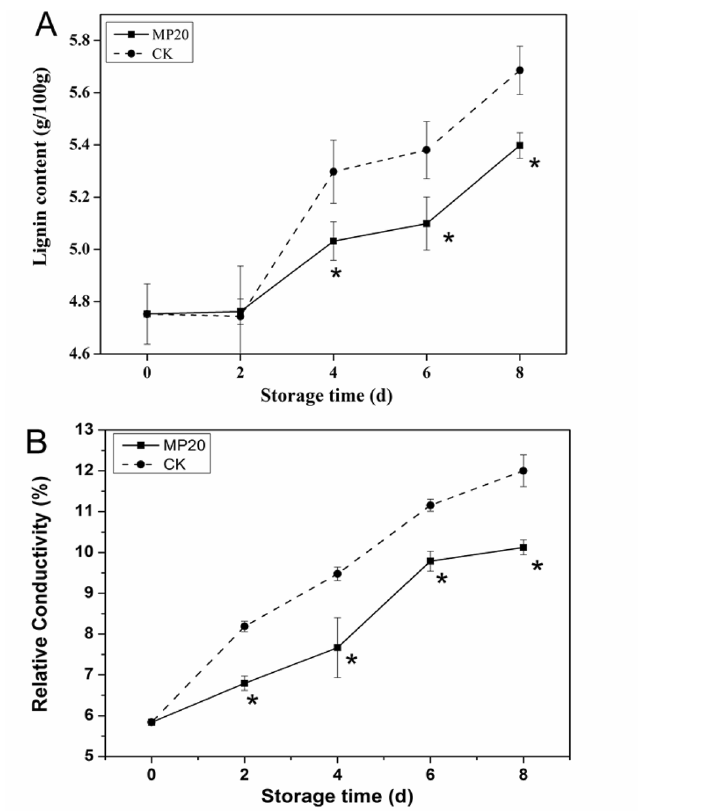
Figure 4. Effect of packaging on lignin content ( A ) and relative conductivity ( B ) of mulberry leaf vegetable during storage. Error bars indicate standard deviation. Asterisks indicate significant differences at the same storage time ( p <